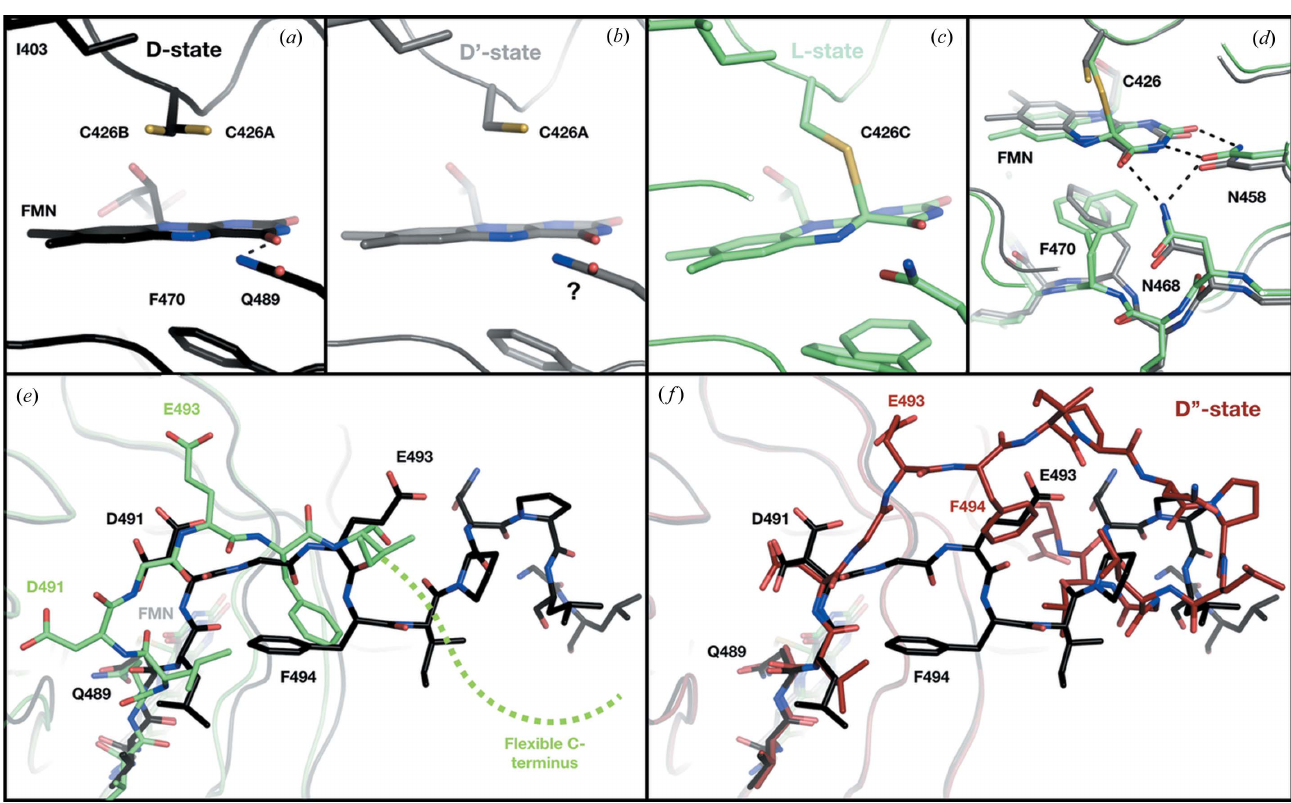
Figure 3 Comparison of the various structures of the ground state and that of the L-state intermediate. Chromophore environments in ( a ) the ‘true’ ground state structure D (carbon atoms in black), ( b ) the ground state structure D 0 present in the PS equilibrium (carbon atoms in grey) and ( c ) the intermediate state structure L present in the PS equilibrium (carbon atoms in green). The question mark in panel ( b ) illustrates the fact that the precise orientation of the Q489 side chain in D 0 cannot be ascertained from our data. C426 has two conformations in D, and only one in D 0 . ( d ) Superposition of the D 0 and L structures on one side of the chromophore in the PS equilibrium. ( e ) Comparison of the conformation of the C-terminus in D and L. In D, residues 496 to 502 form a short (cid:2) -helix, which cannot be modelled in either of the structures of the PS equilibrium. ( f ) Comparison of the structure of the C-terminus in D ( (cid:2) -helical) and in one of the two molecules of D 00 (hook-shaped,